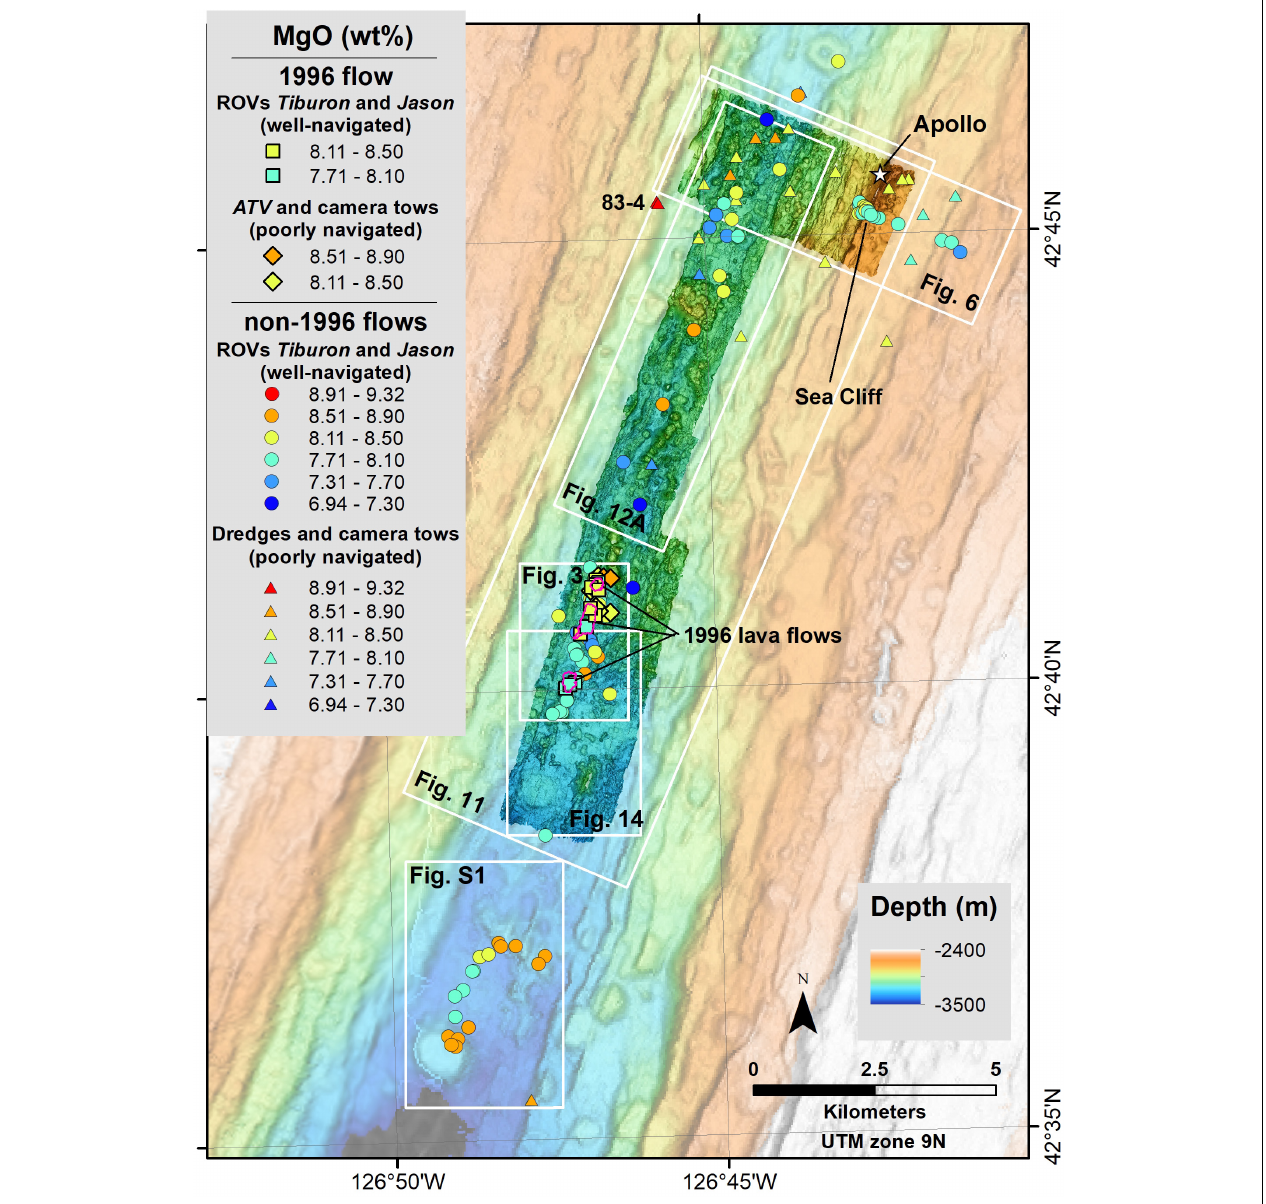
FIGURE 2 | Map of AUV 1-m resolution coverage on top of faded Simrad EM300 and EM302 bathymetry on top of regional multibeam survey data. Lava samples are color-coded by MgO content (using values from Supplementary Table S1 ) with different symbols for 1996 and older samples depending on the reliability of the navigation during collection (Rubin et al., 1998; Davis et al., 2008). Dredged sample 83-4 (Davis and Clague, 1987) has sheet-flow morphology and is the most-MgO-rich lava recovered from the Gorda Ridge. The 1983–1986 dredged samples are plotted at the center of the dredge tracks, and samples recovered on camera sleds that collided with the bottom are located where the camera was inferred to be when it crashed (Davis and Clague, 1987, 1990; Rubin et al., 1998). White boxes indicate the extents of Figures 3 , 6 , 11 , 12A , 14 , and Supplementary Figure S1 . The locations of the Sea Cliff hydrothermal field, newly discovered Apollo vent field (white star) and the 1996 lava flows (with red outline) are labeled.